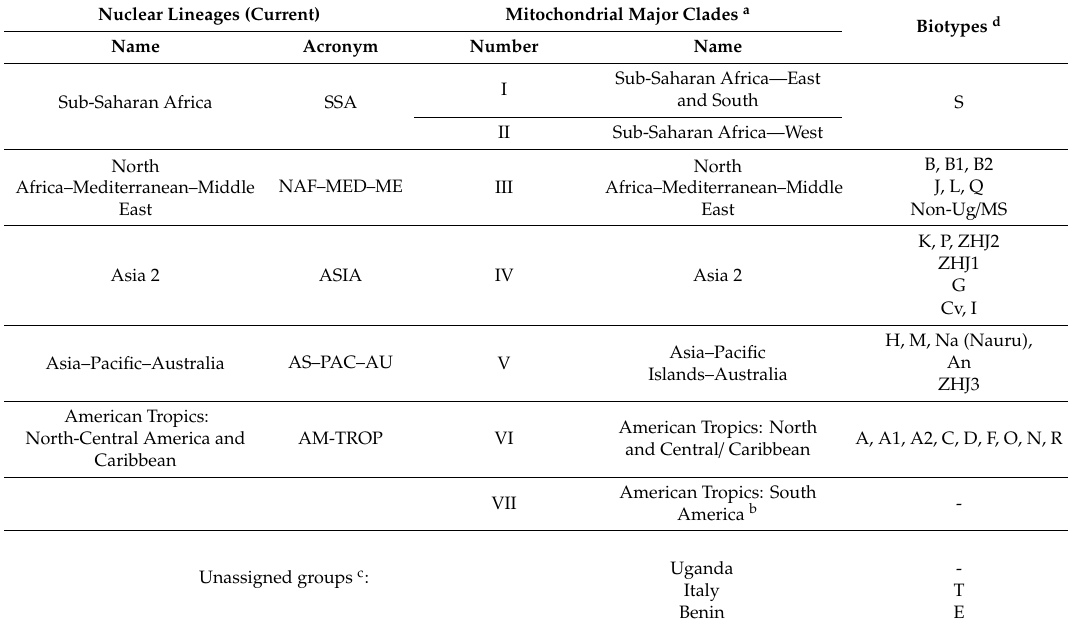
Table 1. Classification of the B. tabaci sibling species group based on nuclear (lineages), mitochondrial (major clades), and esterase / RAPD-PCR patterns